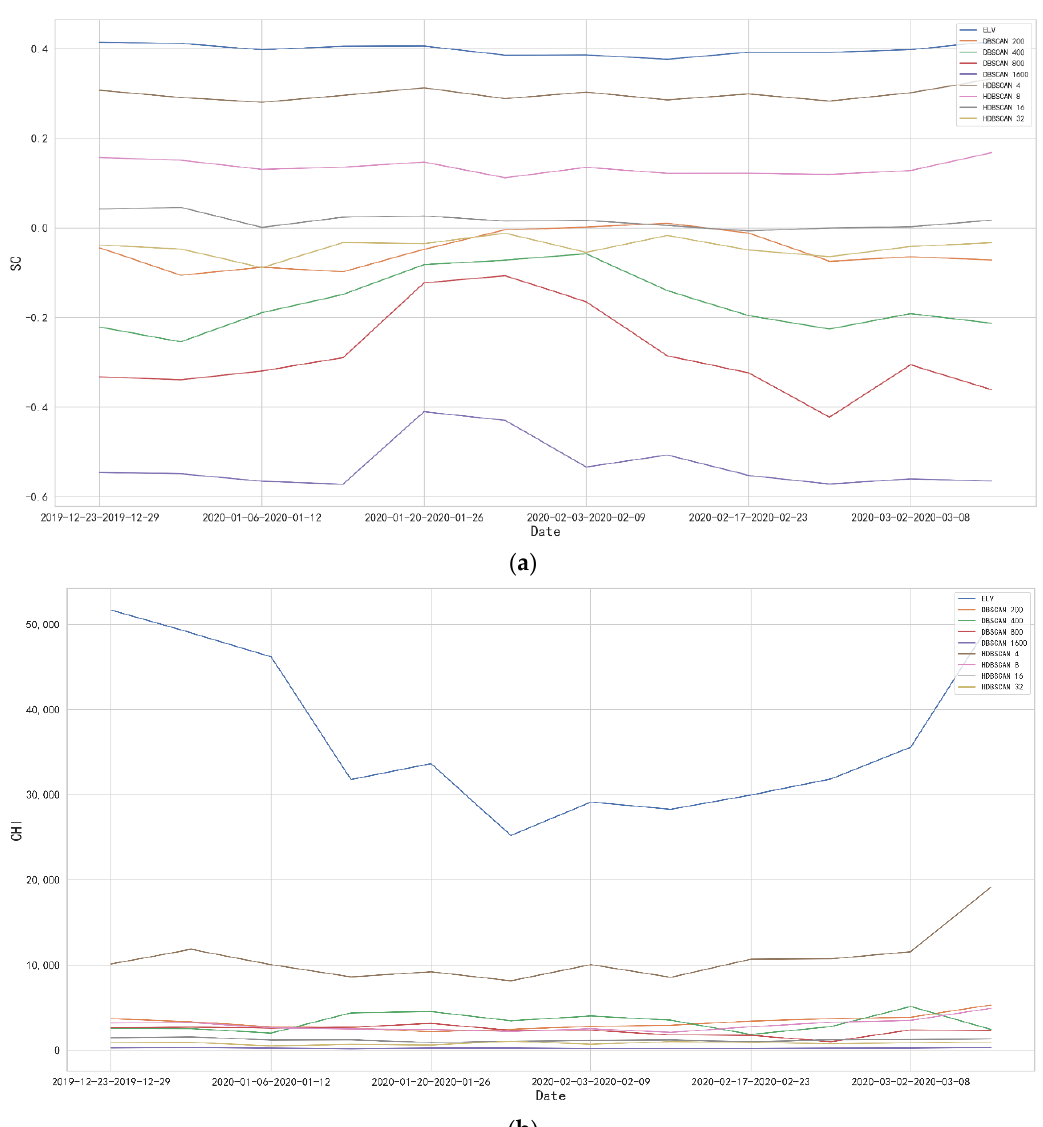
Figure 12. Temporal variation of the different methods evaluated by the two indicators: ( a ) SC and ( b ) CHI.